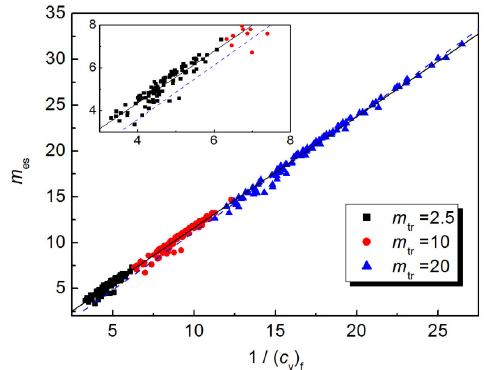
m with ( ) c . Data produced with Fig. 1 Variation of es v f m = 2.5, 10, 25. Solid line: best-fit result of all N = 30 and tr the data; dashed line: best-fit result of only the data m = 20. produced with tr